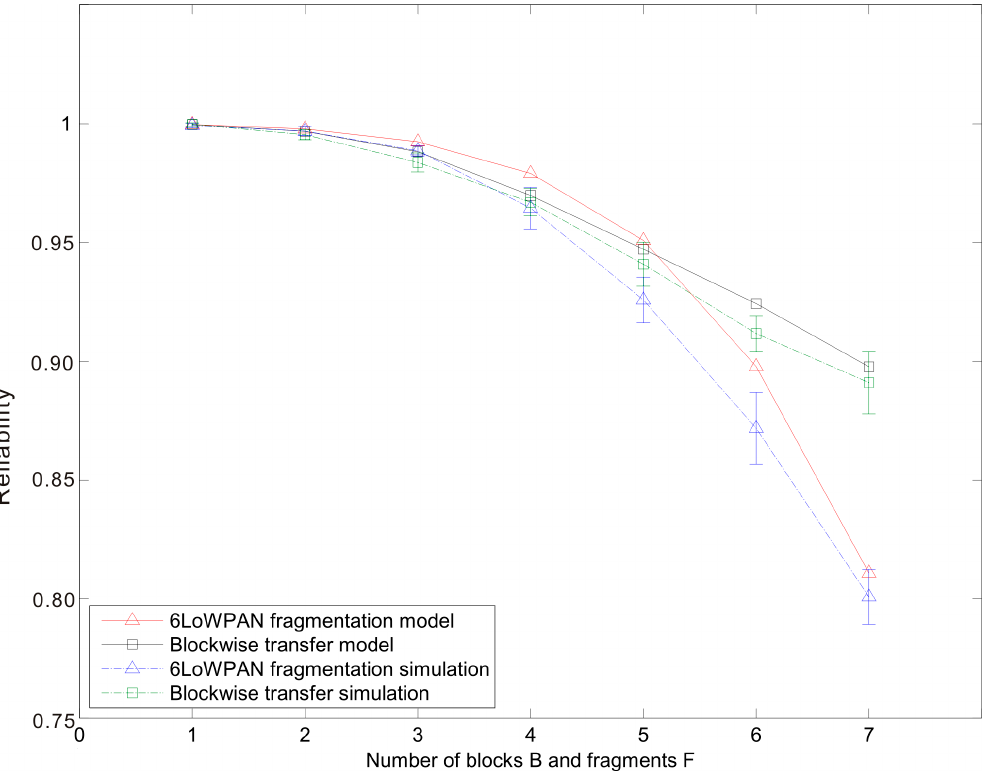
Figure 13. Blockwise and 6LoWPAN reliability versus the number of blocks or fragments that compose an update. The network is composed by 15 nodes and the traffic rate is fixed to 1